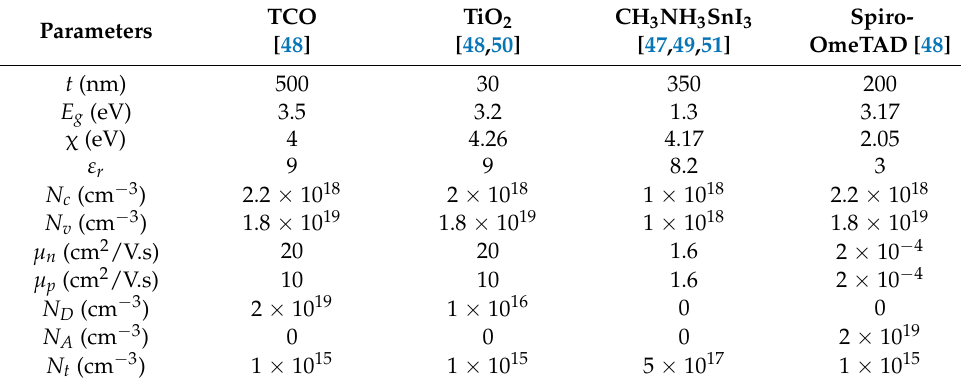
Table 1. Simulation parameters of materials used in simulation of PSC devices.